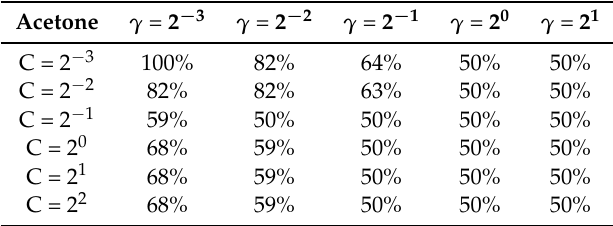
Table 4. Cross-validation process example for